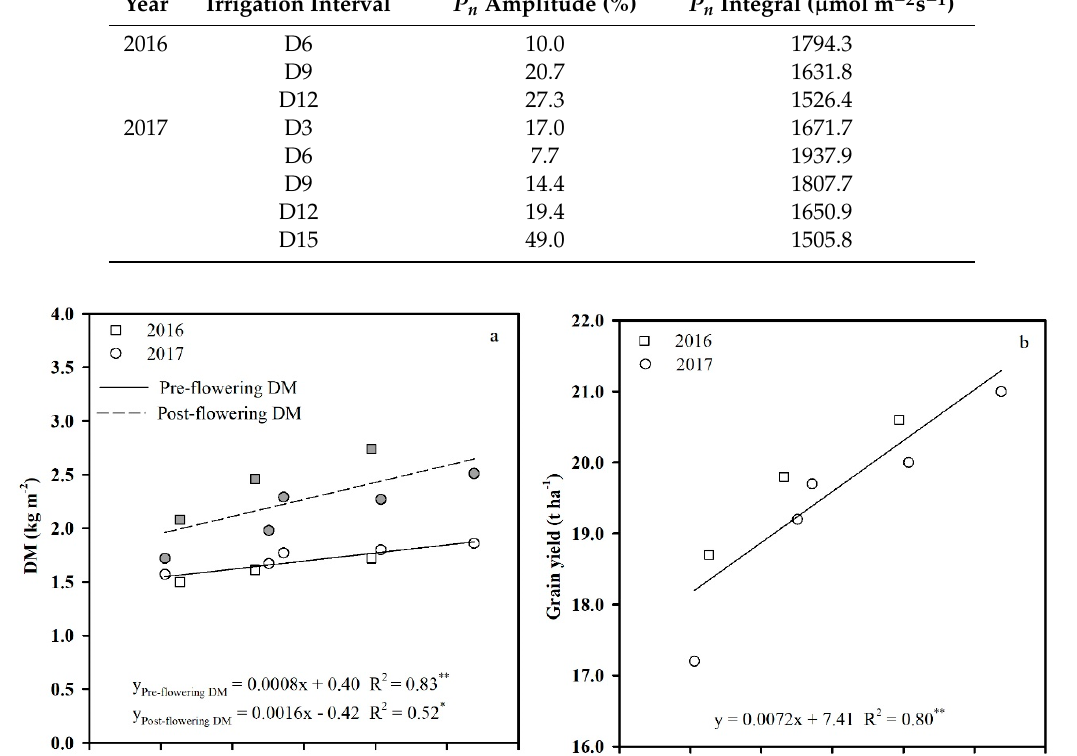
Table 3. Changes of photosynthetic rate amplitude and integral before and after irrigation for di ff erent irrigation intervals.